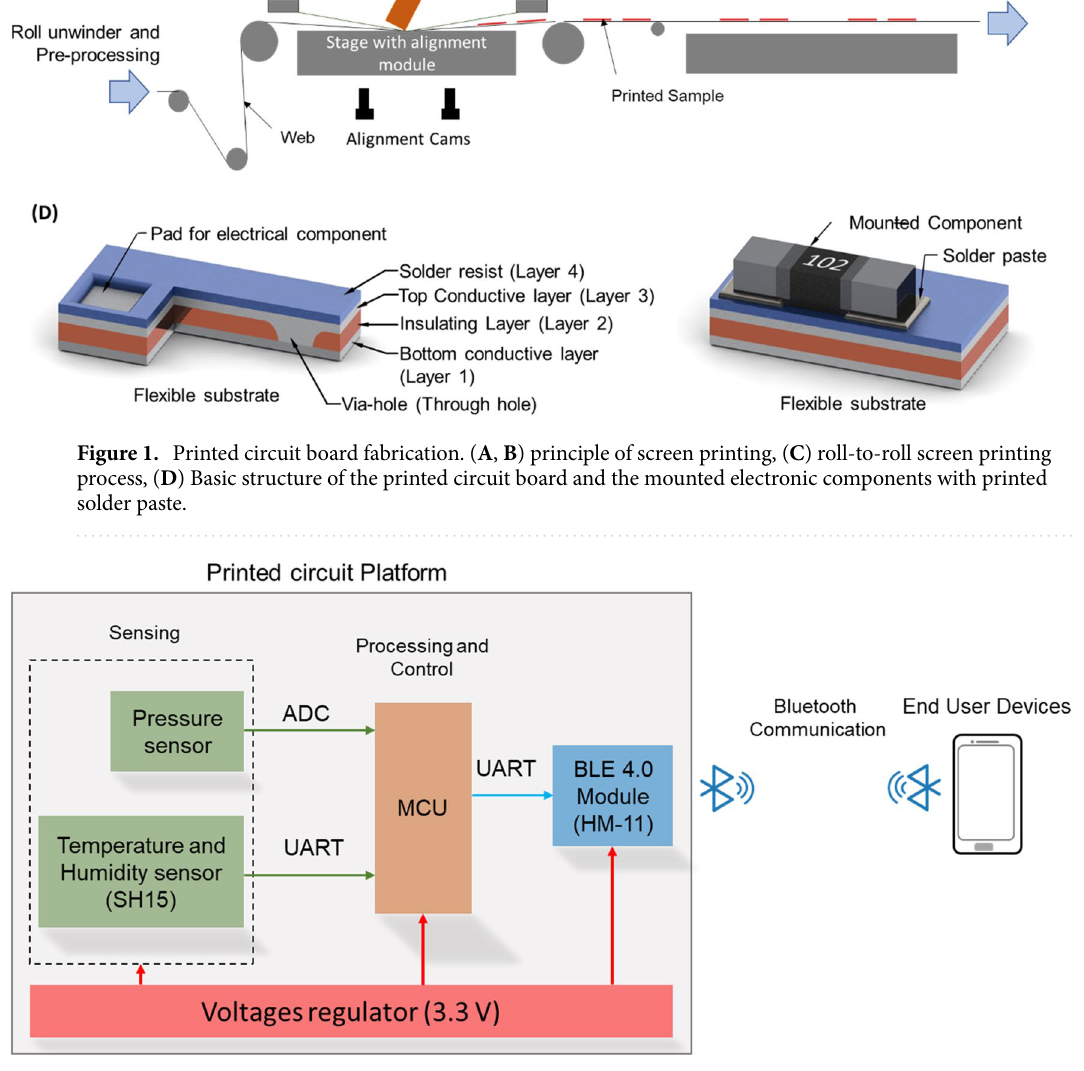
Figure 2. IoT device structure and